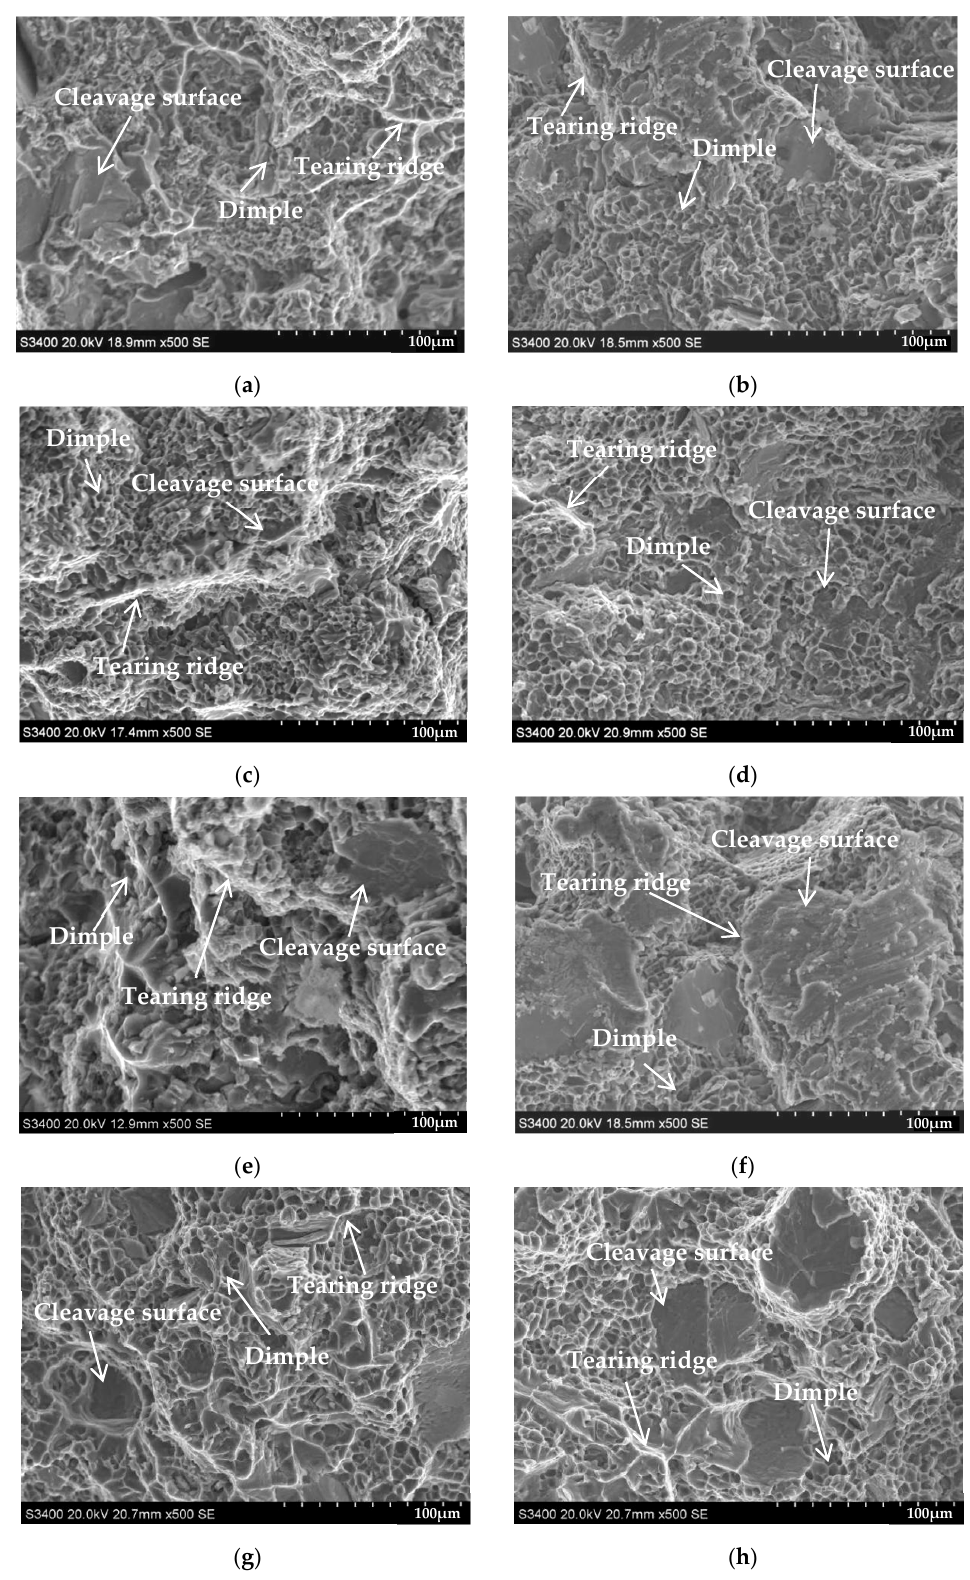
Figure 2. Effect of alloying elements on tensile fracture surface morphology of Al-Si alloys at room (20 ◦ C) and low ( − 60 ◦ C) temperature: ( a ) Al-10Si-0.3Mg, 20 ◦ C; ( b ) Al-10Si-0.3Mg, − 60 ◦ C; ( c ) Al-10Si-0.3Mg-0.2Er, 20 ◦ C; ( d ) Al-10Si-0.3Mg-0.2Er, − 60 ◦ C; ( e ) Al-10Si-3Cu-0.3Mg, 20 ◦ C; ( f ) Al- 10Si-3Cu-0.3Mg, − 60 ◦ C; ( g ) Al-10Si-3Cu-0.3Mg-0.2Er, 20 ◦ C; ( h ) Al-10Si-3Cu-0.3Mg-0.2Er, − 60 ◦